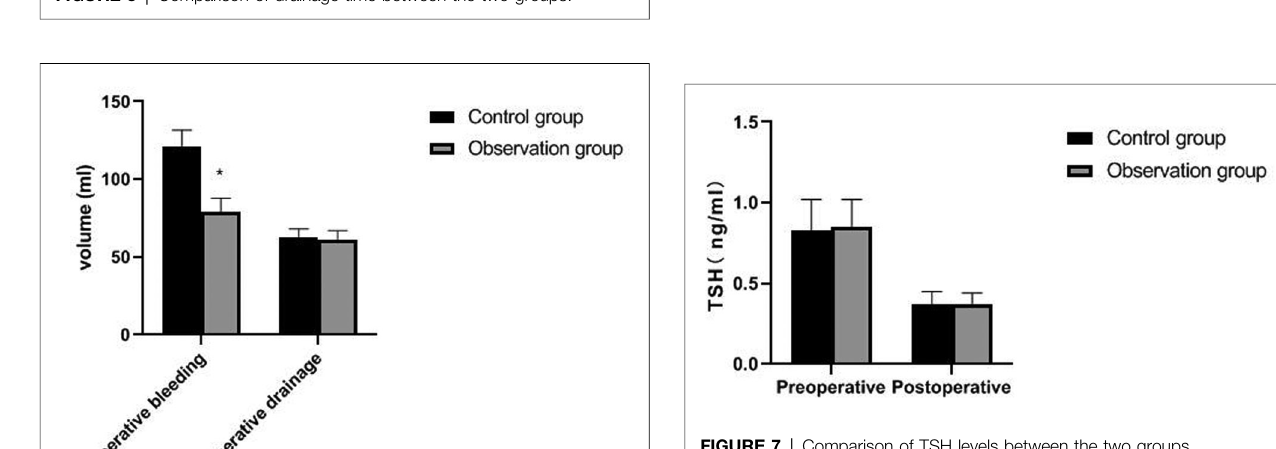
FIGURE 3 | Comparison of drainage time between the two groups.